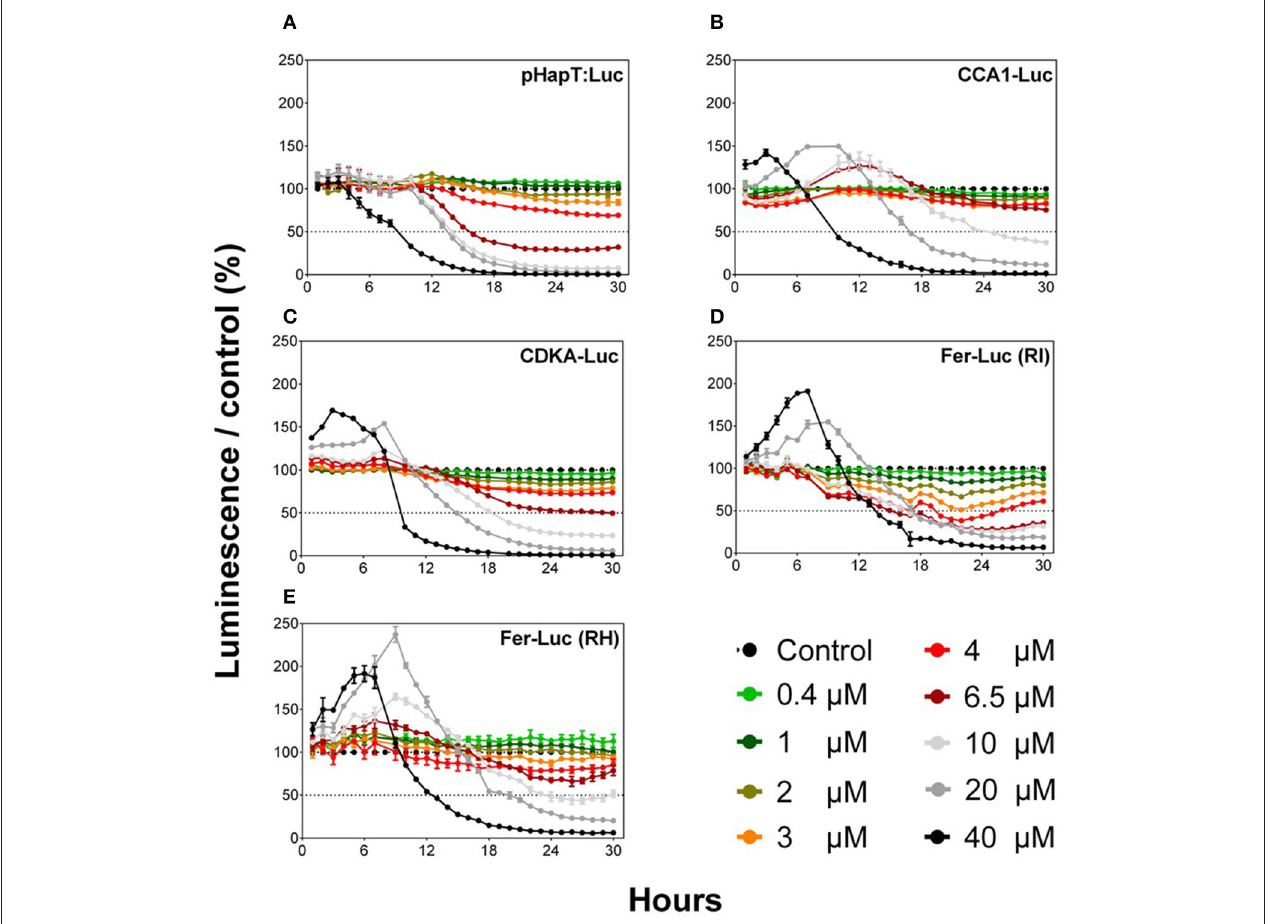
FIGURE 1 | Comparison of the different O. tauri reporter luminescent lines after exposure to different Cu concentrations. Graphs represent normalized data compared to the control (KASW, 20nM of Cu). Values represent the means ± SEM for triplicate wells.